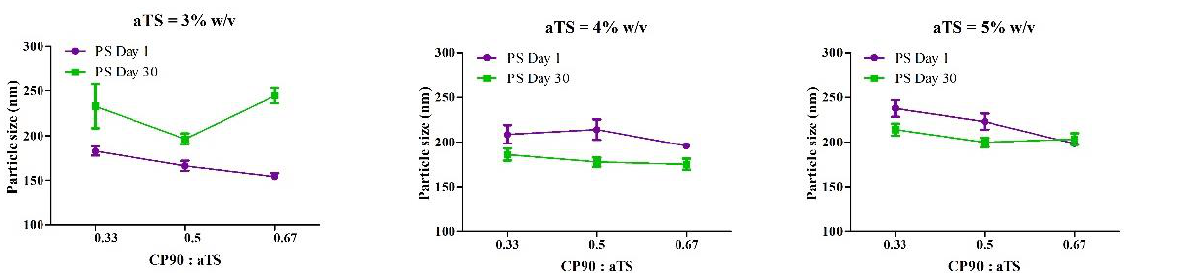
Figure 2. Descriptive plots for the effect of the amount of αTS and CP90:αTS ratio on the particle size when the concentration of αTS is 3%, 4% and 5%.